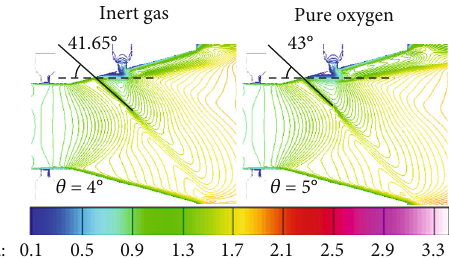
Figure 16: Mach Contour of fl ow fi eld injected in divergence section.